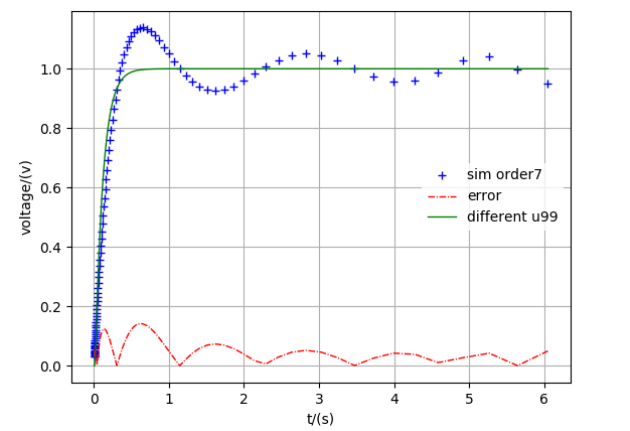
Figure 8. Simulation